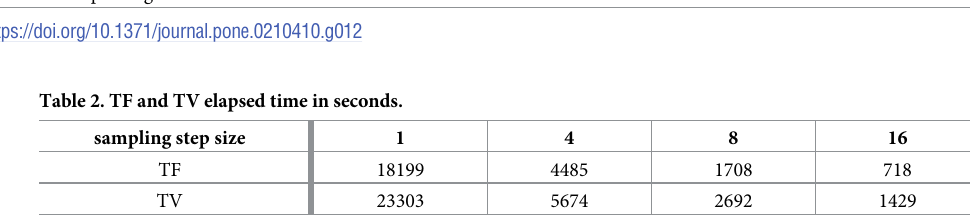
S1 Fig. Data related to Fig 1.